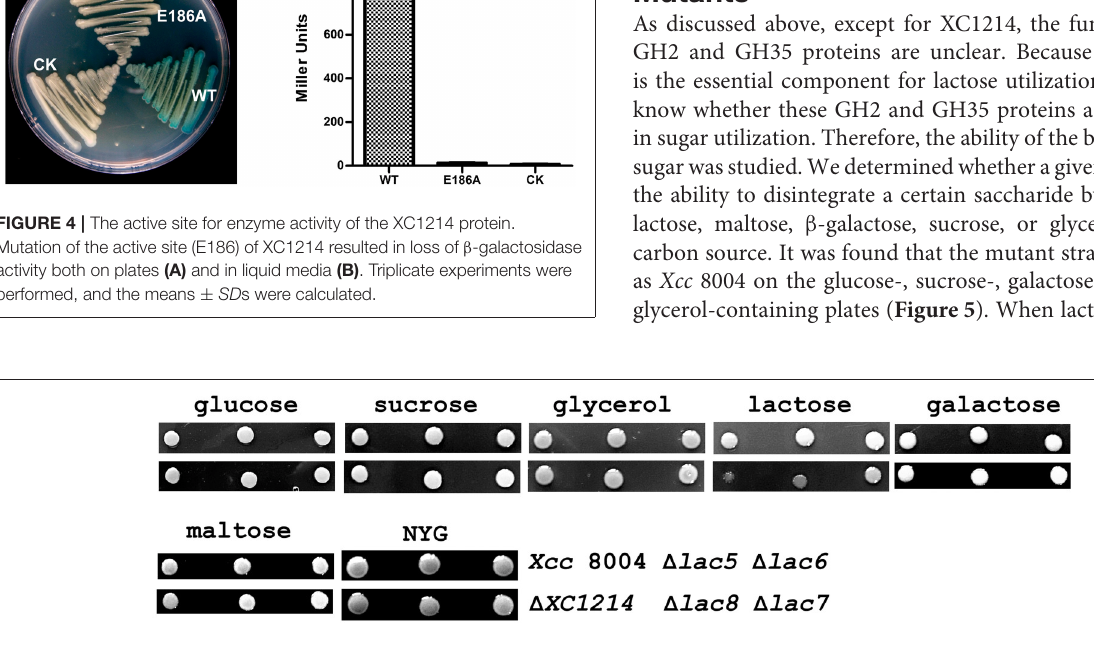
FIGURE 5 | The sugar usage of the GH2 and GH35 mutants in Xcc 8004. The growth of the indicated strains (right end panel) on solid plates when the individual sugars were used as the sole carbon source. 1 lac5 : 1 XC1003 / 1 XC2985 / 1 XC4208 / 1 XC2481 / 1 XC1708 ; 1 lac6 : 1 lac5 / 1 XC4194 ; 1 lac7 : 1 lac6 / 1 XC1218 ; 1 lac8 : 1 lac7 / 1 XC1214